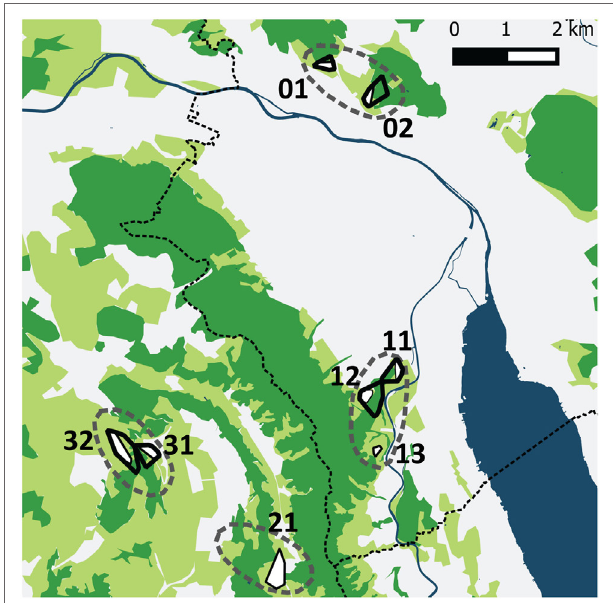
FigUre 1 | The four study sites (dashed lines) in the urban periphery of Zürich and the rural surroundings. Two sites were situated near to the city border and contained five trapping plots (01, 02 and 11, 12, 13) and two sites in rural settings contained three tapping plots (21 and 31, 32). The dotted line shows the border of the community of Zurich. The different colors represent water surfaces (dark blue), forests (dark green), cultivated (light green; mainly meadows and pastures), and urban areas (white). Black outlined polygons are the trapping plots for all four vole species, the white areas within these polygons are meadows and pastures where Arvicola scherman and Microtus arvalis were trapped. Myodes glareolus and Microtus agrestis have been trapped in the immediate neighborhood to these fields in scrubland and forest